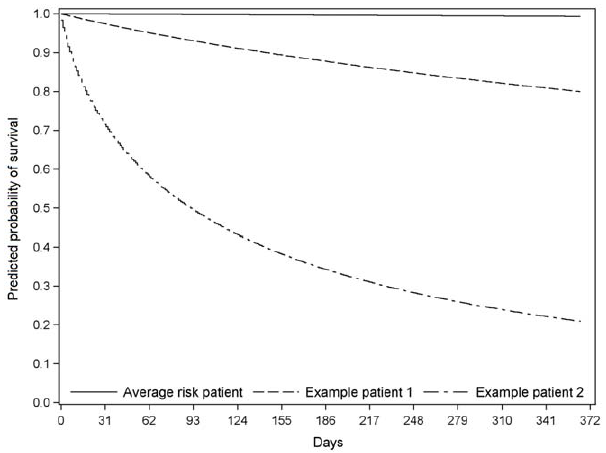
Figure 4. Predicted probability of surviving during the year for the average risk patient and two example cases. Example 1 patient: 55 year old male, albumin=28 g/L, ALP=137 U/L, biliru- bin=9 m mol/L, GGT=86 U/L and transaminase=41 U/L. Example 2 patient: 54 year old male, history of cancer, albumin= 38 g/L, ALP=1133 U/L, bilirubin=8 m mol/L, GGT=114 U/L and transamina- se=25 U/L. Probability of surviving up to one year for each of these patients was 0.99, 0.80, and 0.21